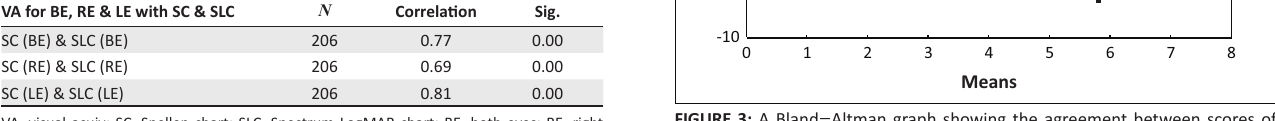
TABLE 2: Paired sample correlations of the visual acuities obtained using a Snellen chart and Spectrum LogMAR chart for both eyes, right eyes and left eyes. VA for BE, RE & LE with SC & SLC N Correlation Sig.